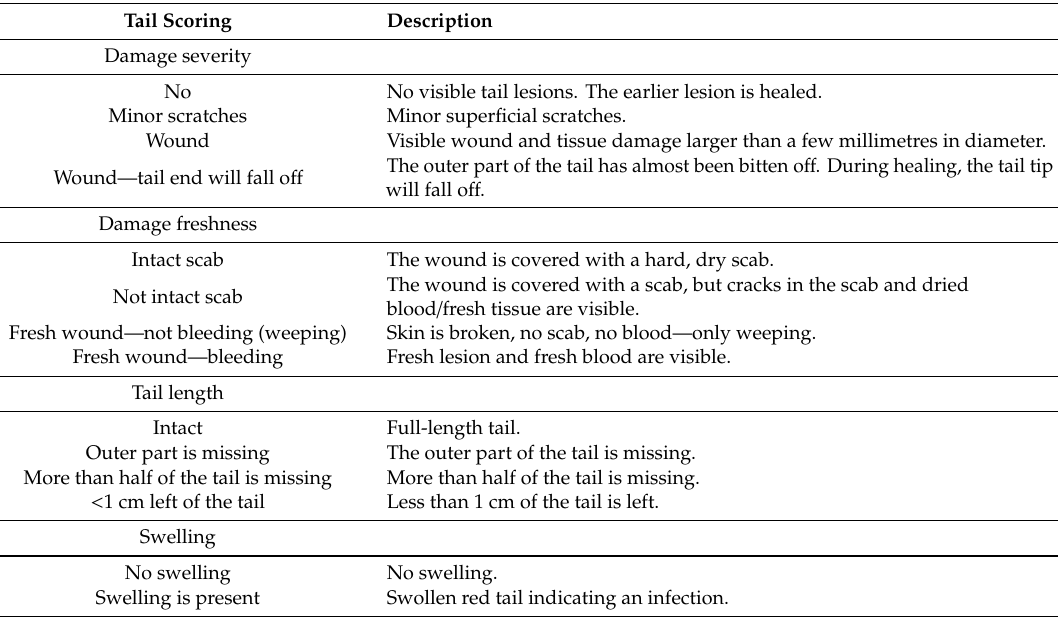
Table 1. Tail injury classification after Lahrmann et al.